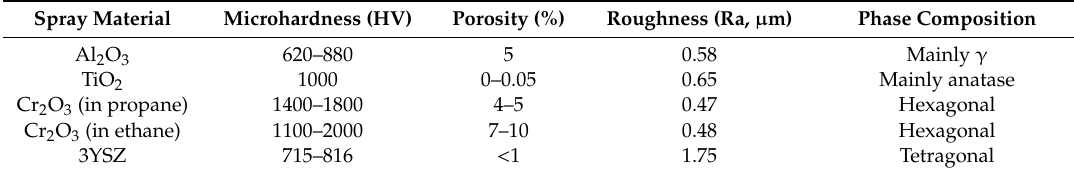
Table 1. Summary of characteristics of di ff erent materials used for coating of pure Ti with HVSFS process